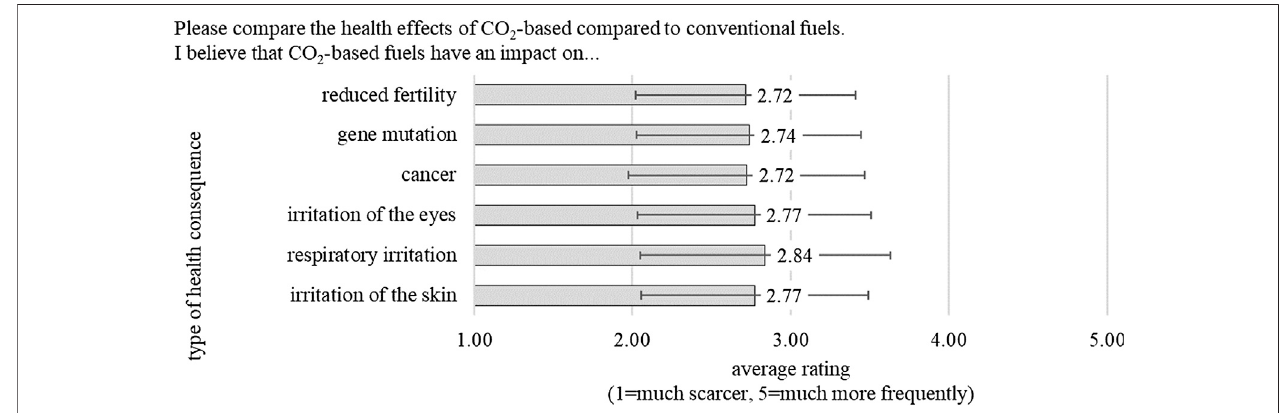
FIGURE 4 | Perceived frequency of health consequences caused by CO 2 -derived fuels compared to conventional fuels.